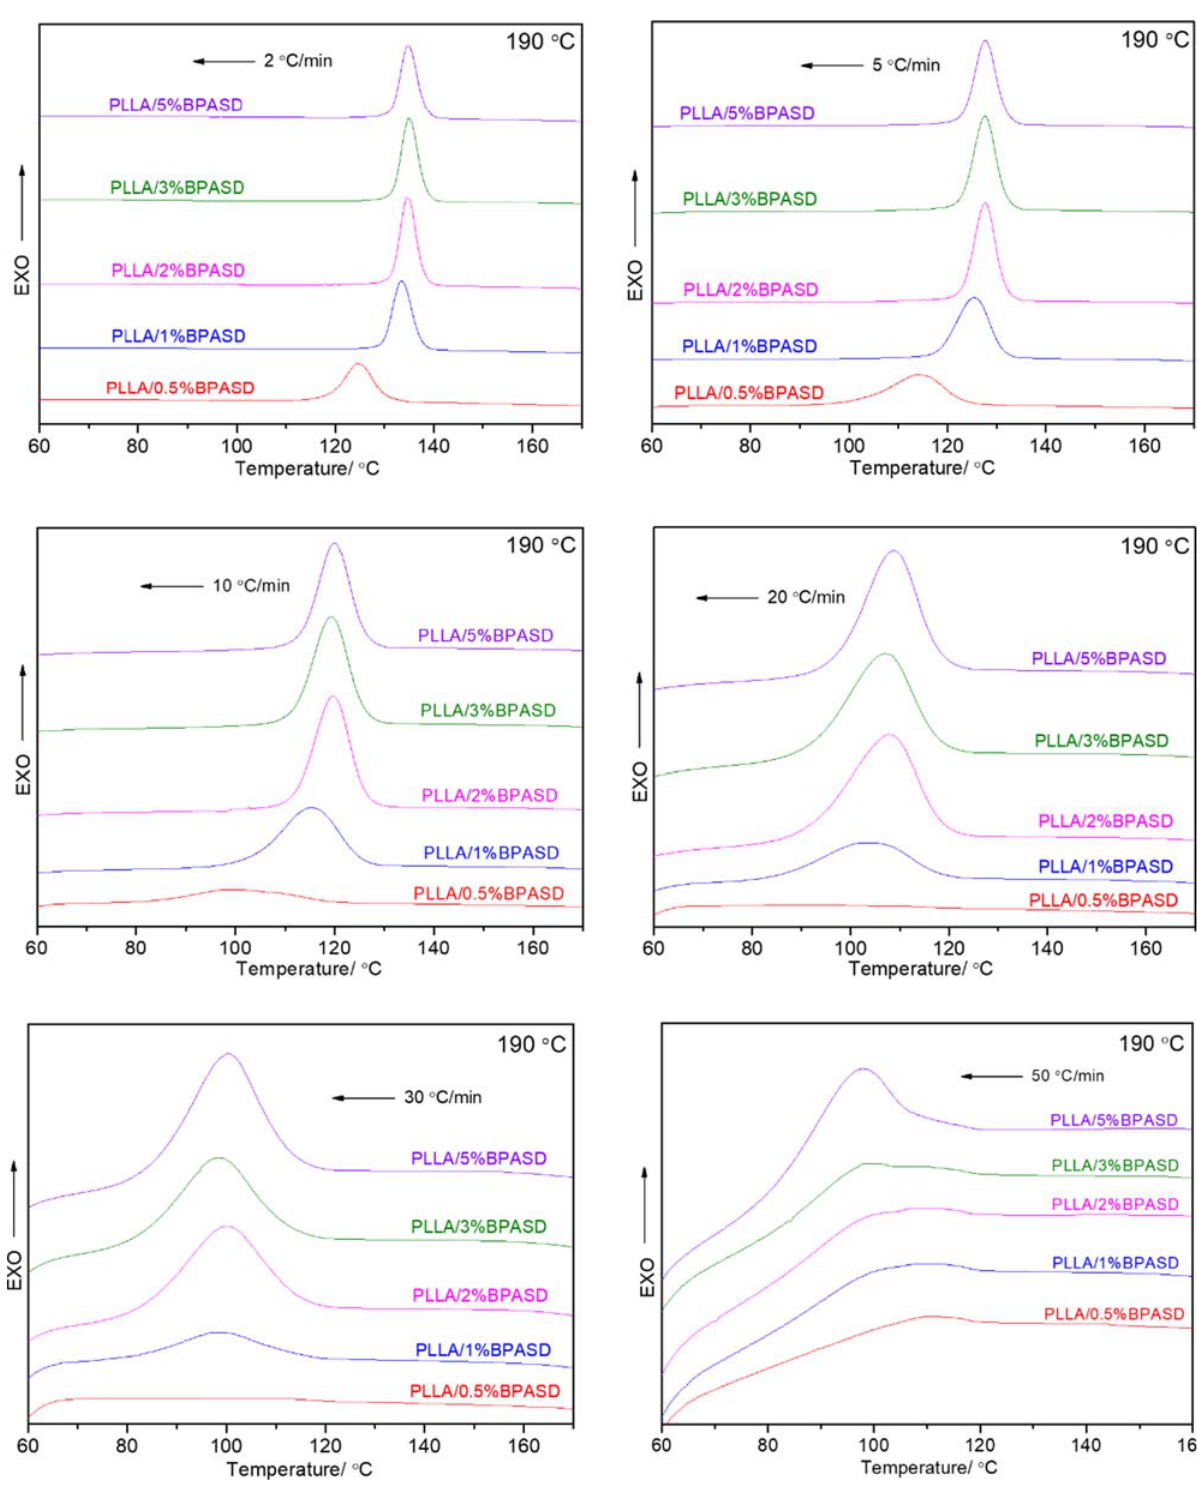
Figure 3: Melt - crystallization DSC curves of PLLA/BPASD samples from 190 ℃ at di ff erent cooling